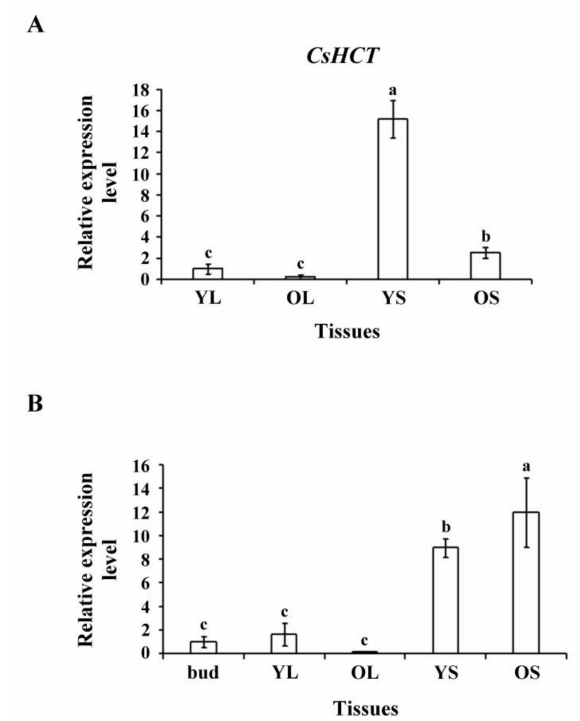
Figure 3. CsHCT transcription levels in various tissues of tea plants; qRT-PCR analysis of CsHCT transcription levels in various tissues of ( A ) tea seedlings and ( B ) tea plants. Total RNA was